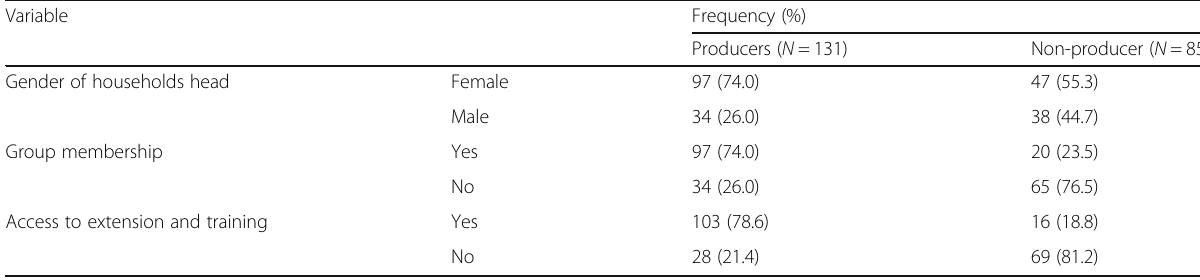
Table 4 Hypothesized variables used in the model